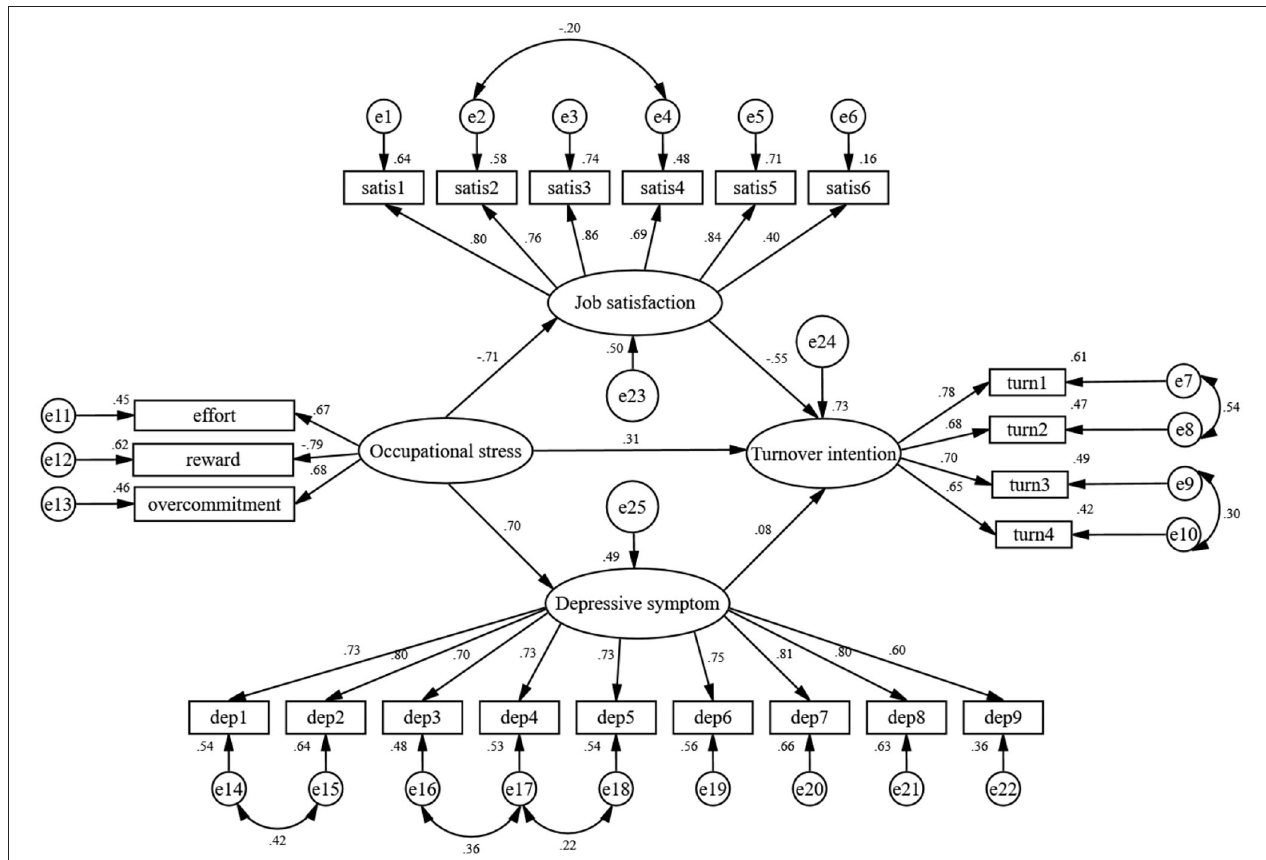
FIGURE 2 | The structural equation model on the relationships between occupational stress, job satisfaction, depressive symptom and turnover intention. Three subscales of the Effort Reward Imbalance Questionnaire labeled effort, reward, and overcommitment. Questionnaire items of the Leiden Quality of Work Questionnaire labeled satis1–satis6. Questionnaire items of the PHQ-9 labeled dep1–dep9. Questionnaire items of Turnover Intention scale labeled turn1–turn4. e1–e22, the measurement error of each observed variable to estimate latent variable. e23–e25, the residual that may affect the endogenous latent variables except the exogenous latent